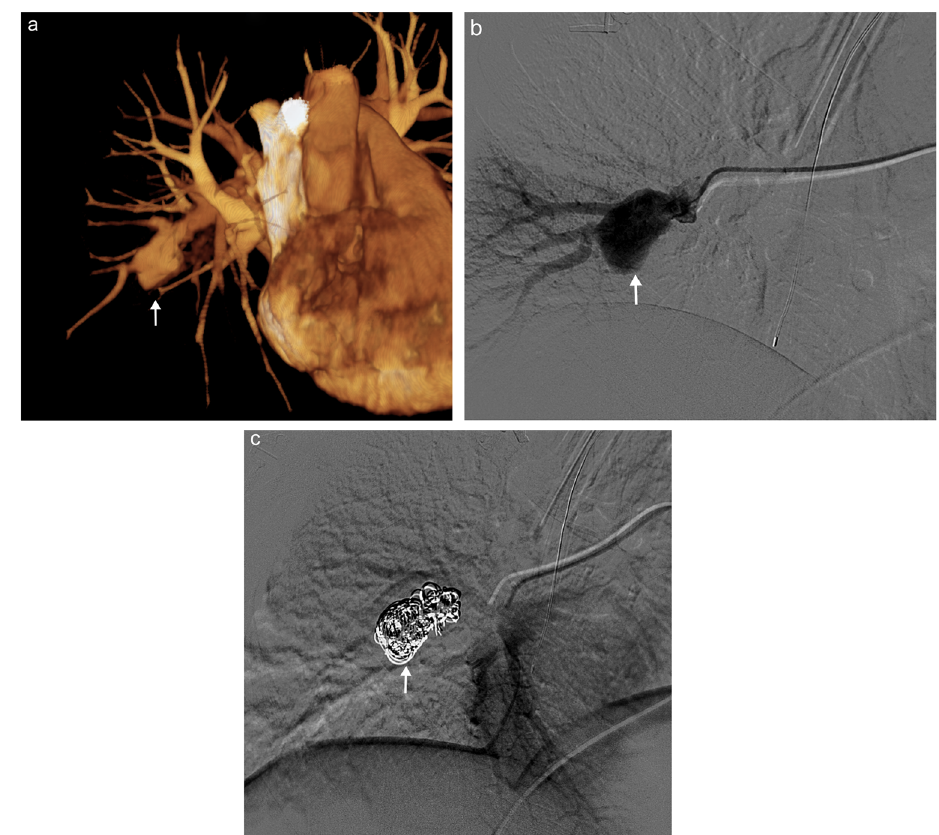
Fig. 7 Pulmonary artery aneurysm in a patient with Behçet ’ s disease. a Three- dimensional reconstruction from a contrast-enhanced CT scan showing a right lower lobe pul- monary artery aneurysm in a pa- tient with Behçet ’ s disease ( white arrow ). Digital subtraction fluo- roscopic images obtained before ( b ) and after ( c ) coil embolisation of the right lower lobe pulmonary aneurysm ( white arrow )